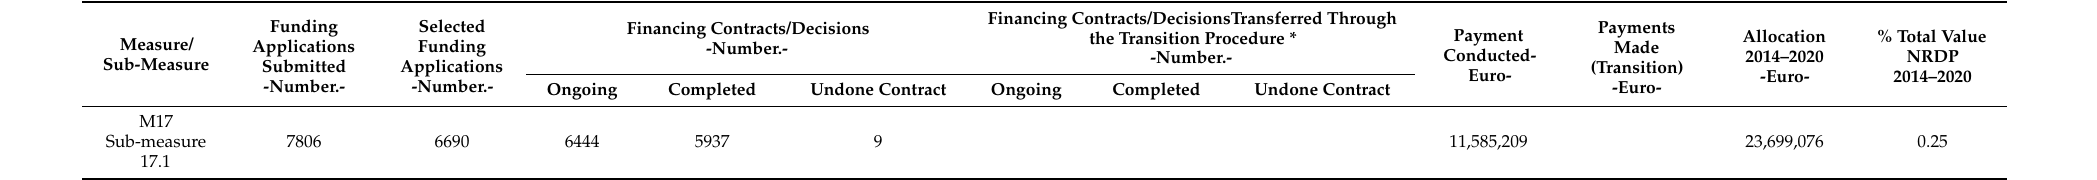
Table 1. The stage of the implementation of NRDP 2014–2020 on